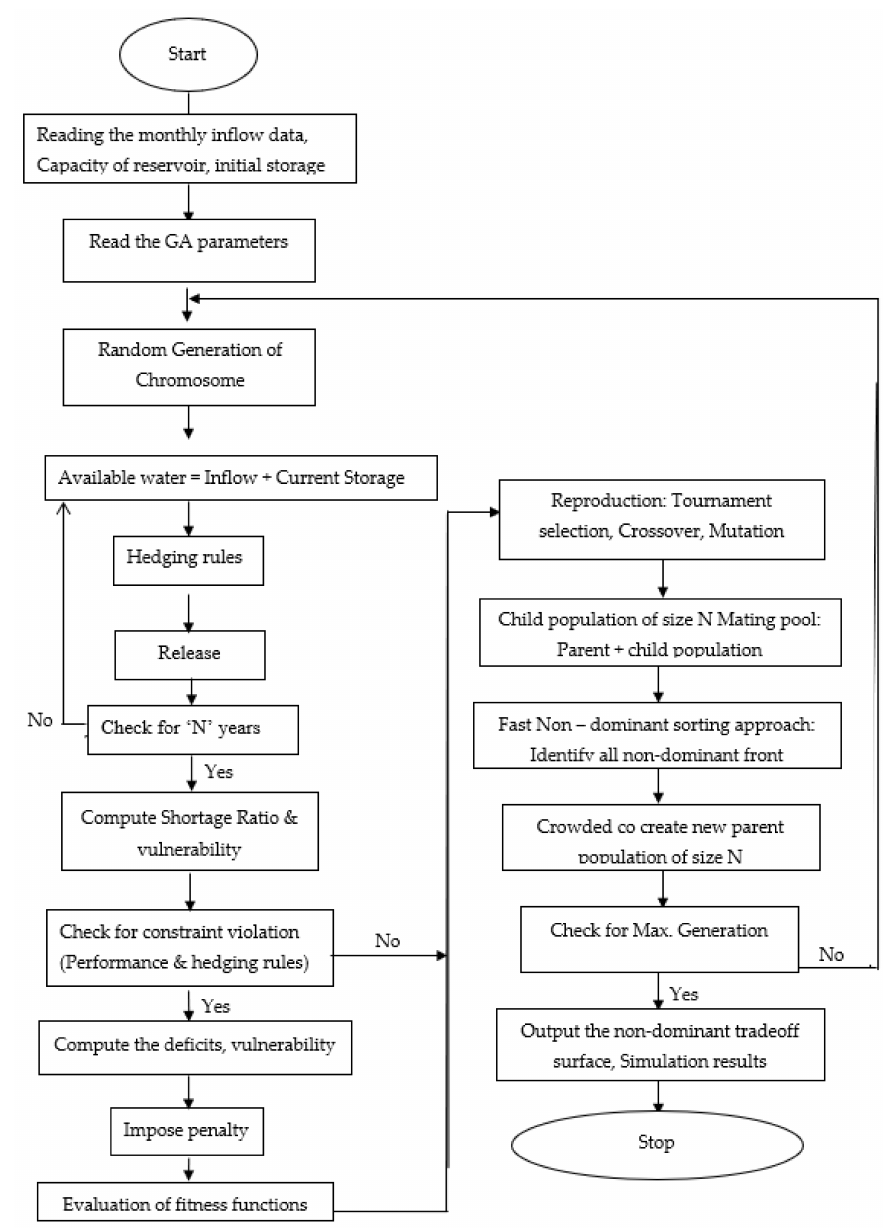
Figure A1. Block diagram of PSO frame work for single purpose reservoir